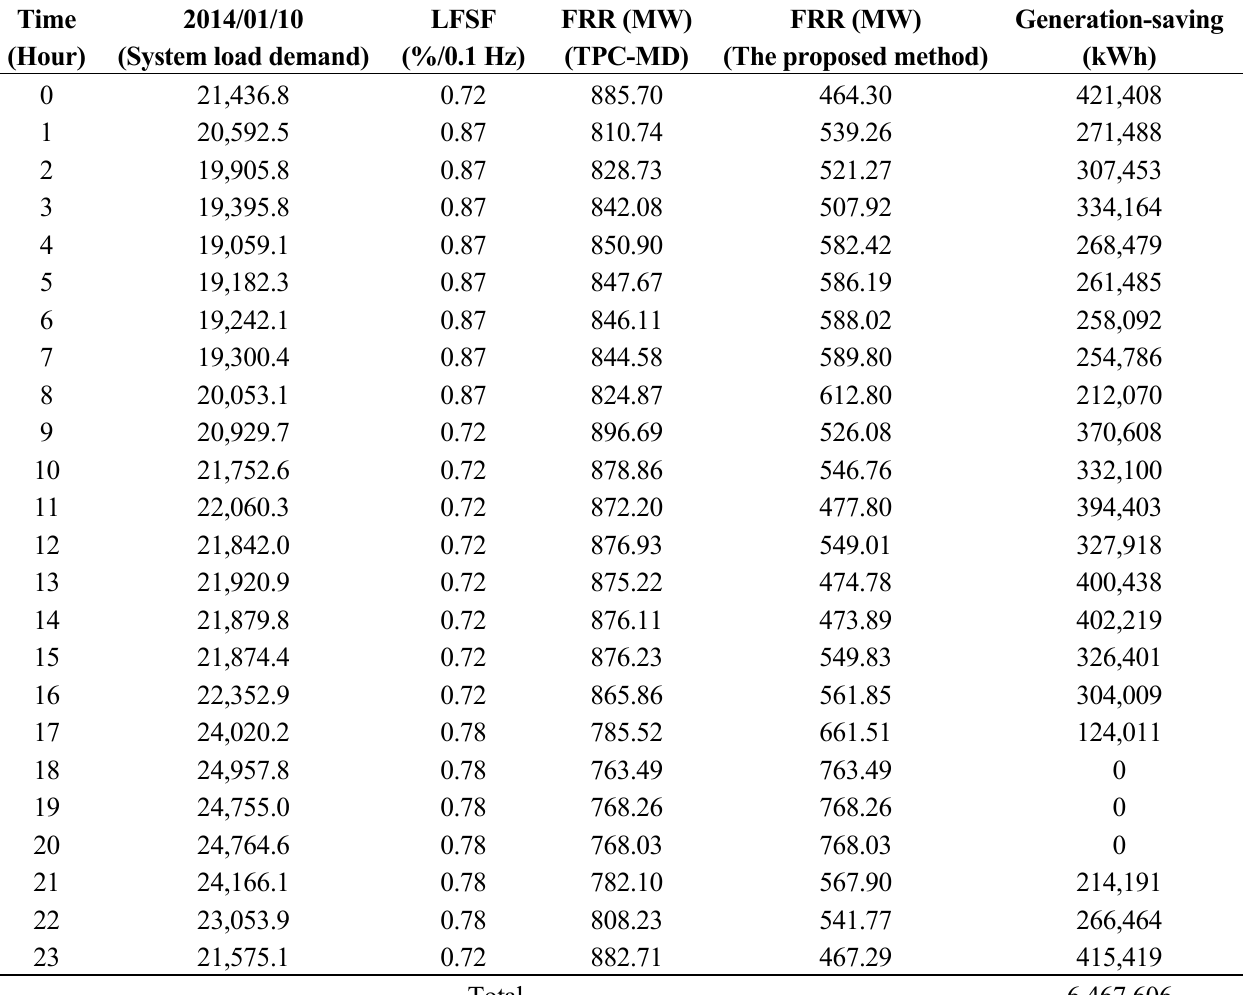
Table 2. Comparison of FRR in winter weekend between the proposed method and